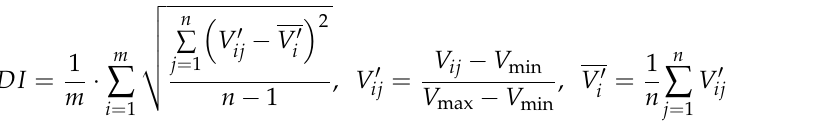
Figure 3. Conveyor mixer used in the experiment of the binary mixture (painted limestone particles) particle, used for mixing experiments ( a ), the scheme of mixing principle ( b ), coupling of vertical static mixer and conveyor mixer ( c